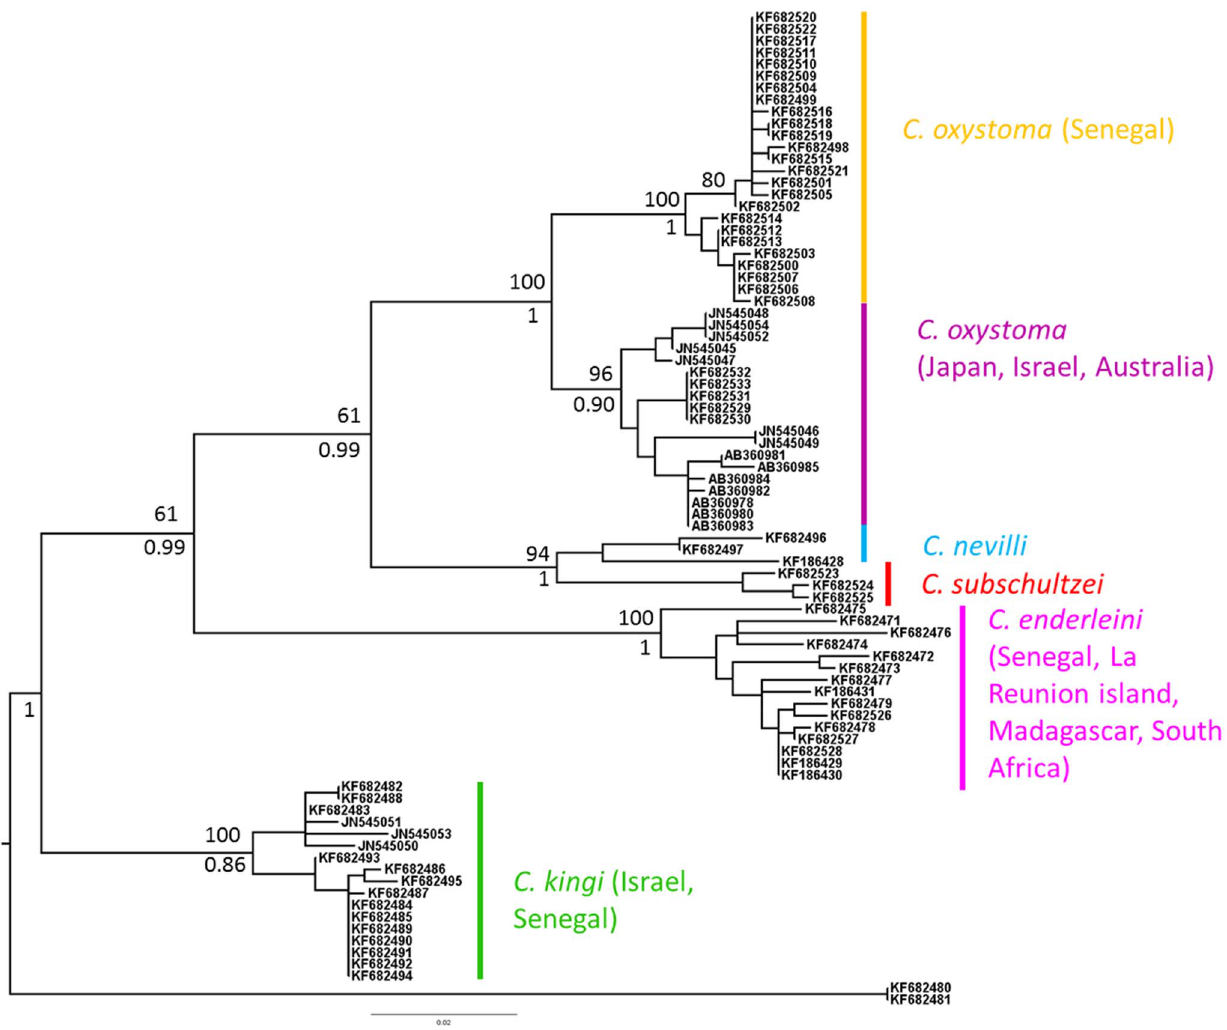
Figure 4. Phylogenetic analysis of species of the Schultzei group using COI sequence data. The topology shows Bayesian inference tree using program MrBayes. Culicoides imicola was designated as an outgroup taxon. Numbers indicate bootstrap values from ML (bottom) analyses, and posterior probabilities from Bayesian analysis (top). Only bootstrap values . 60% and Bayesian posterior probabilities . 0.5 are shown. Branch lengths represent nucleotide substitutions per site.